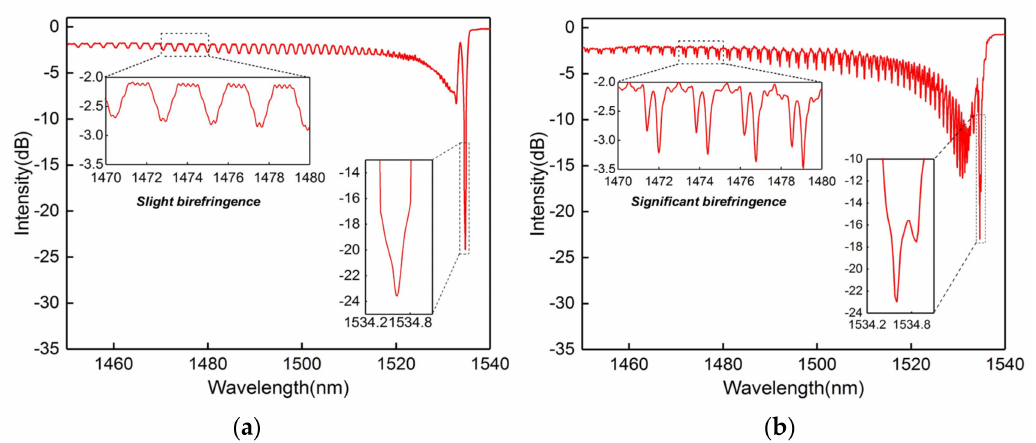
Figure 2. Transmission spectrum of the fiber Bragg grating (FBG) without ( a ) and with ( b ) enhanced cladding modes (inset: magnified spectrum of cladding modes and core mode from 1470 to 1480 nm).